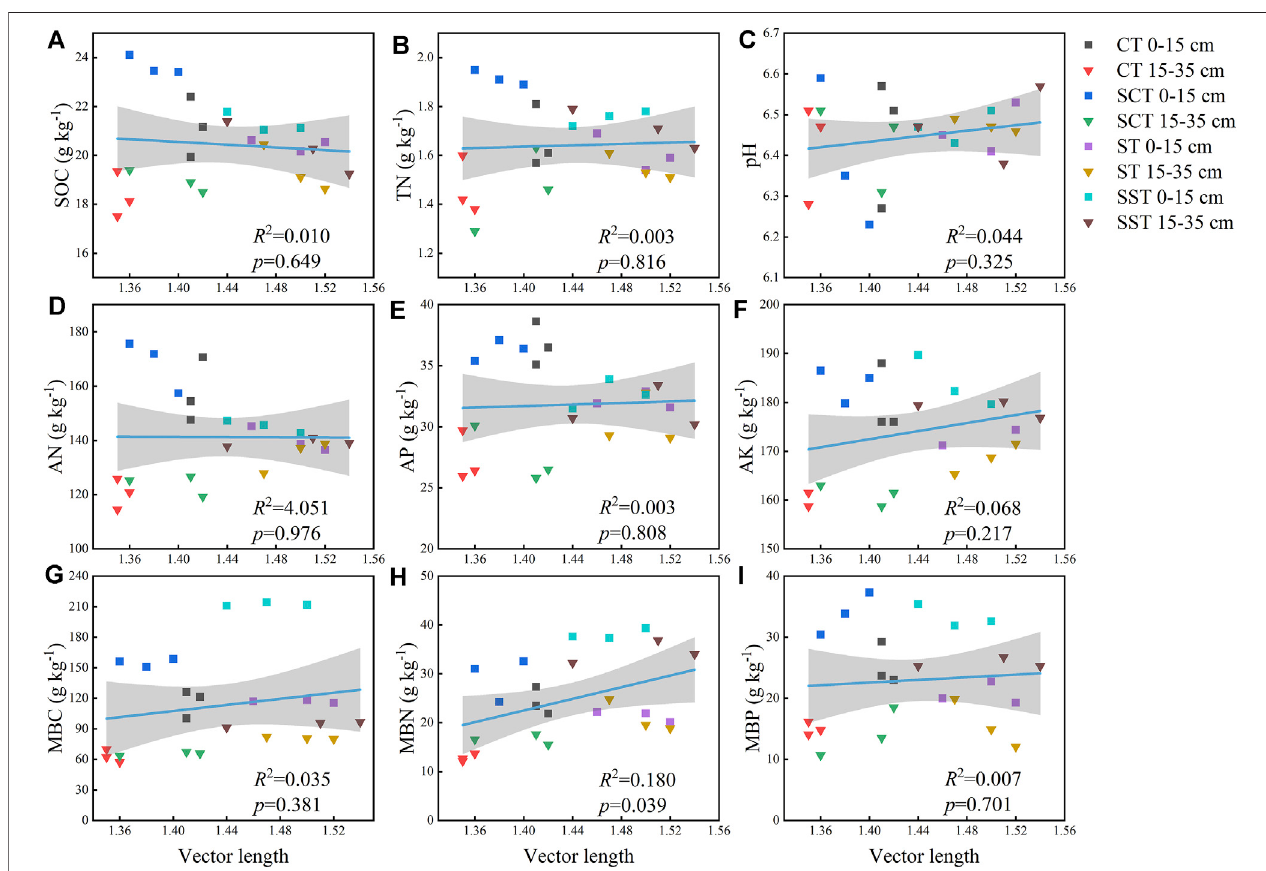
FIGURE 4 | Vector lengths for the soil properties (A – I) . Solid lines indicate that the model fi t the vector lengths and the properties well, and the gray areas are the 95% con fi dence intervals of the models. See Materials and methods for abbreviation de fi nitions.